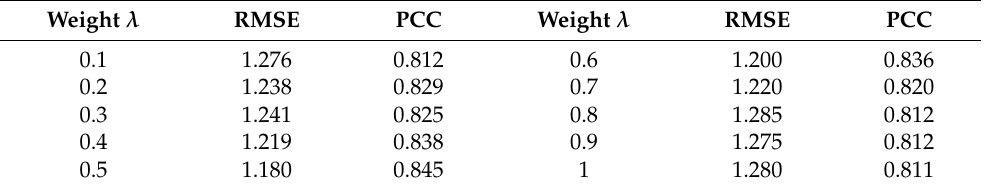
Table 2. Part of the results of the contrast experiments. An evenly trained model with λ = 0.5 achieves the best performance.